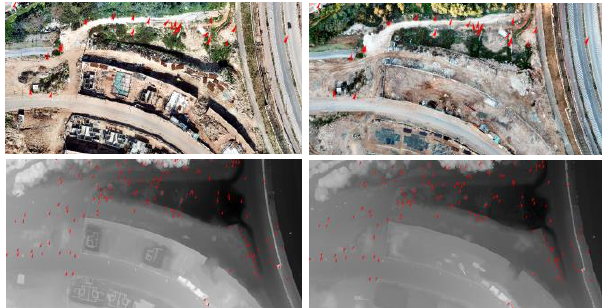
Figure 5. Point identification in the two databases: orthophoto (top) and DEM (bottom) representation, 26 and 212 homological points, respectively.